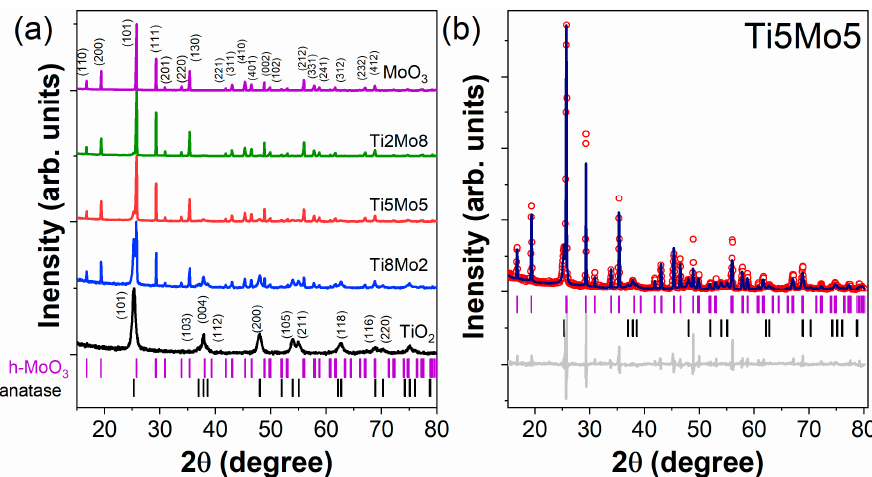
Figure 2. X-ray diffraction patterns for all studied TiO 2 -MoO 3 composites, where for the most pronounced peaks, Miller indices are given ( a ). Example of Rietveld refinement for selected Ti5Mo5 sample ( b ). The solid line through the experimental points represents a fitted model. The difference between the experimental and theoretical curves is represented by the lower solid line. Upper and lower ticks represent Bragg positions corresponding to the h-MoO 3 and anatase phases respectively.